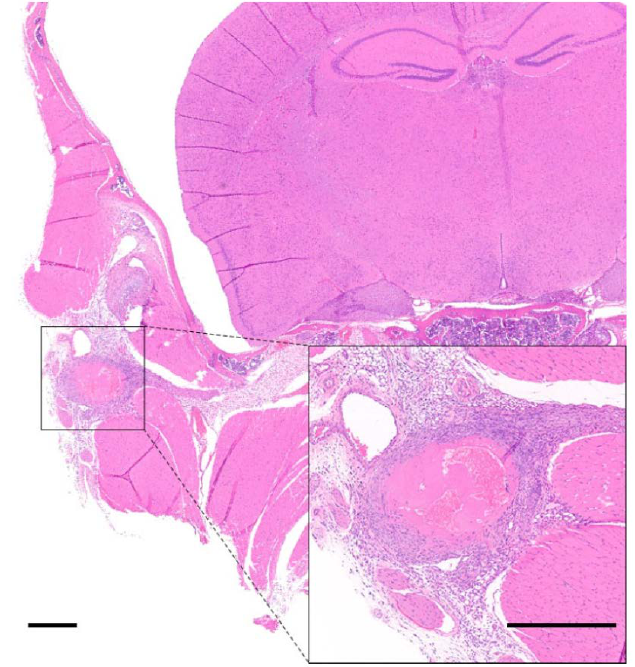
Figure 5. Lesion associated with facial vein puncture. Example of occlusive venous thrombus in the facial vein with abundant perivascular inflammation and granulation tissue. H&E stain. Scale bars, 500 µ